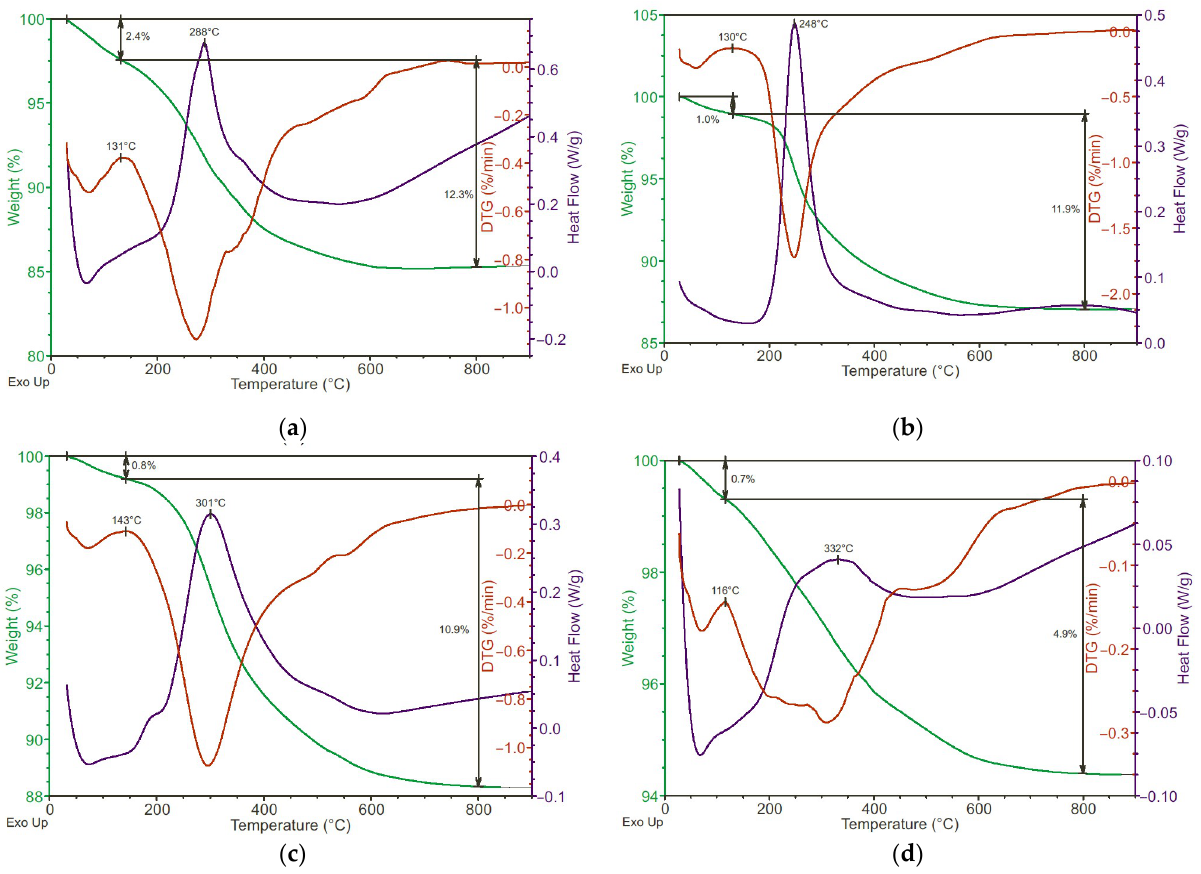
Figure 4. Simultaneous thermal analysis of alumina nanofibers. ( а ) Alumina nanofibers coated by butylamine groups, ( b ) alumina nanofibers coated by epoxypropyl groups, ( c ) alumina nanofibers coated by metacryl groups, and ( d ) alumina nanofibers coated by vinyl groups.